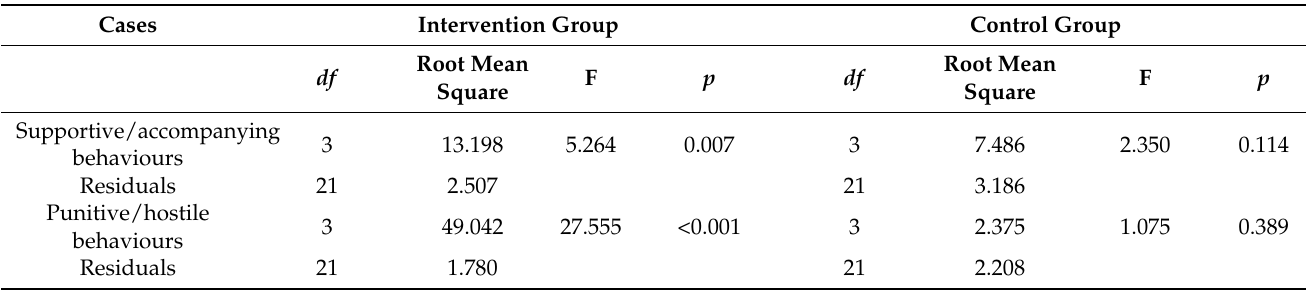
Table 8. Statistical significance of the changes in estimated parenting behaviours for intervention and control group.